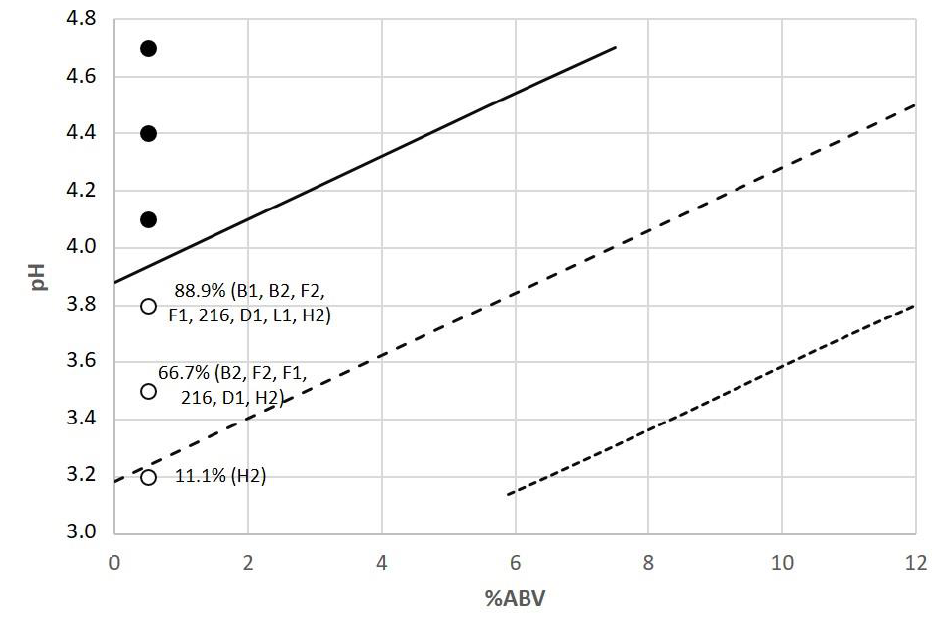
Figure 4. Contour plots for the observed growth responses and predicted probabilities (P = 0.1 ( ⋯⋯ ), P = 0.5 (- - -), and P = 0.9 (—)) for the microbial spoilage of craft beer as a function of % ABV and pH. Values of IBU and % YFE were set at 11 and 1.45, respectively. (●) P = 1 (growth), ( ○ ) P = 0 (no growth). Percentages indicate the proportion of strains showing growth, being described between brackets.